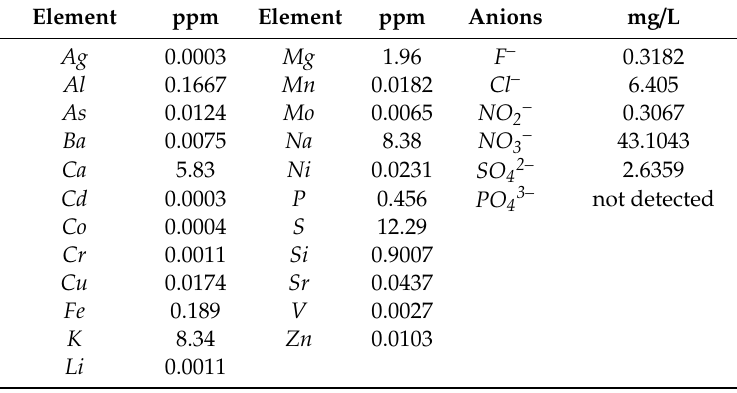
Table 1. Chemical characteristics of the moraine and ice sample [Nz